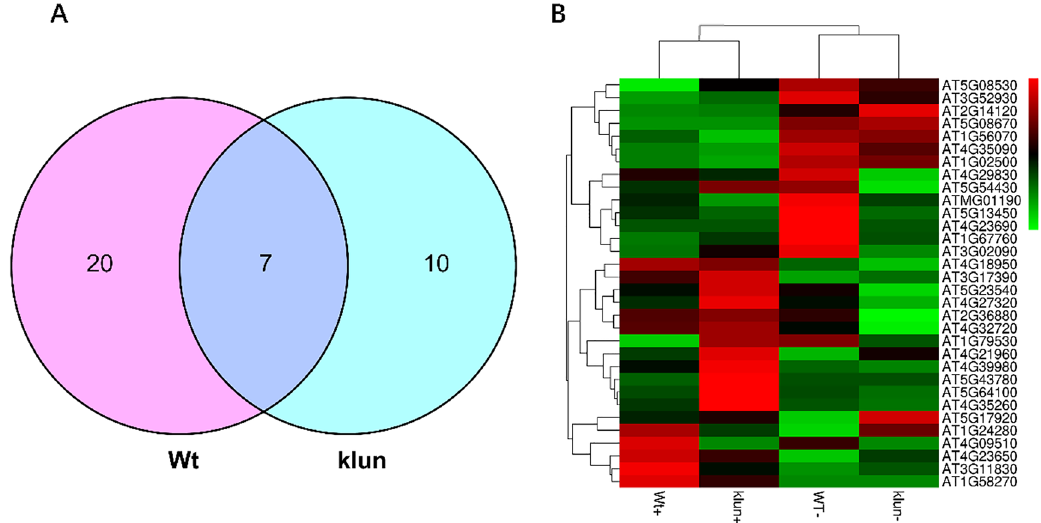
Figure 6. The changes of 14-3-3 interaction in Wt roots or klun roots induced by Fe-deficiency. ( A ) The Venn diagram of changed interactors identified in the comparison between Fe-sufficient and Fe-deficient condition in Wt and klun. B Heatmap of changed interactors identified in the comparison between Fe-sufficient and Fe-deficient condition in Wt and klun pull-down experiment.